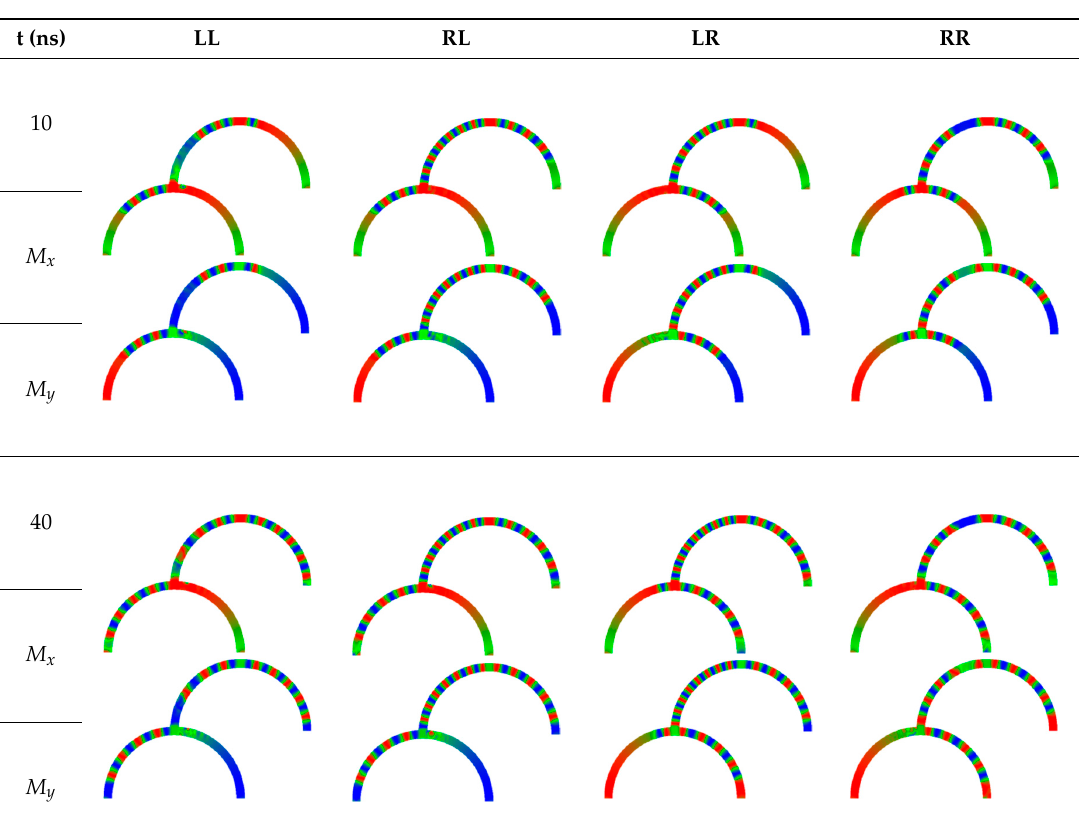
Table 1. Results of di ff erent rotational orientations at both inputs after 10 ns and 40 ns, respectively. Table 1. Results of different rotational orientations at both inputs after 10 ns and 40 ns, respectively. Table 1. Results of different rotational orientations at both inputs after 10 ns and 40 ns, respectively. Table 1. Results of different rotational orientations at both inputs after 10 ns and 40 ns, respectively. Table 1. Results of different rotational orientations at both inputs after 10 ns and 40 ns, respectively.